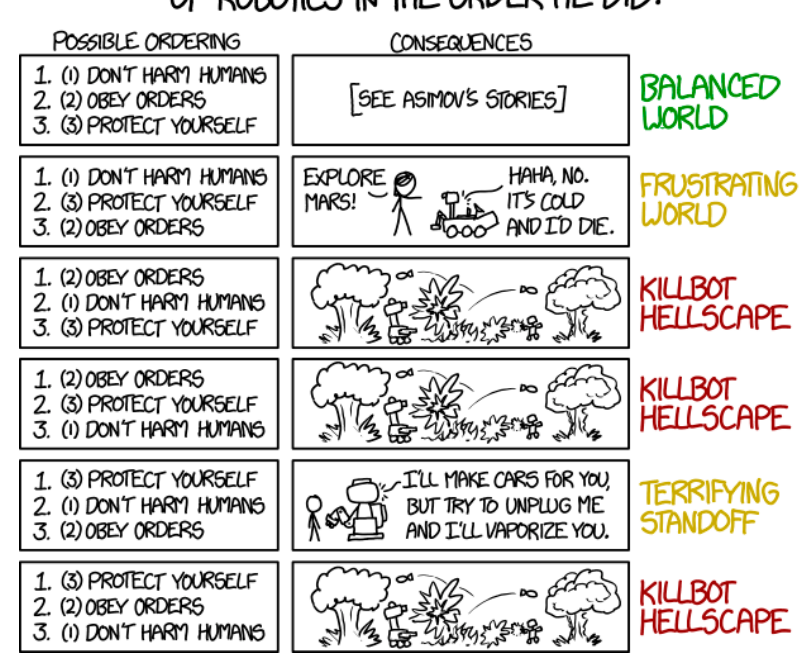
Figure 3. The Three Laws of Robotics, by Randall Monroe. Creative Commons Attribution. Source: https://xkcd.com/1613/.